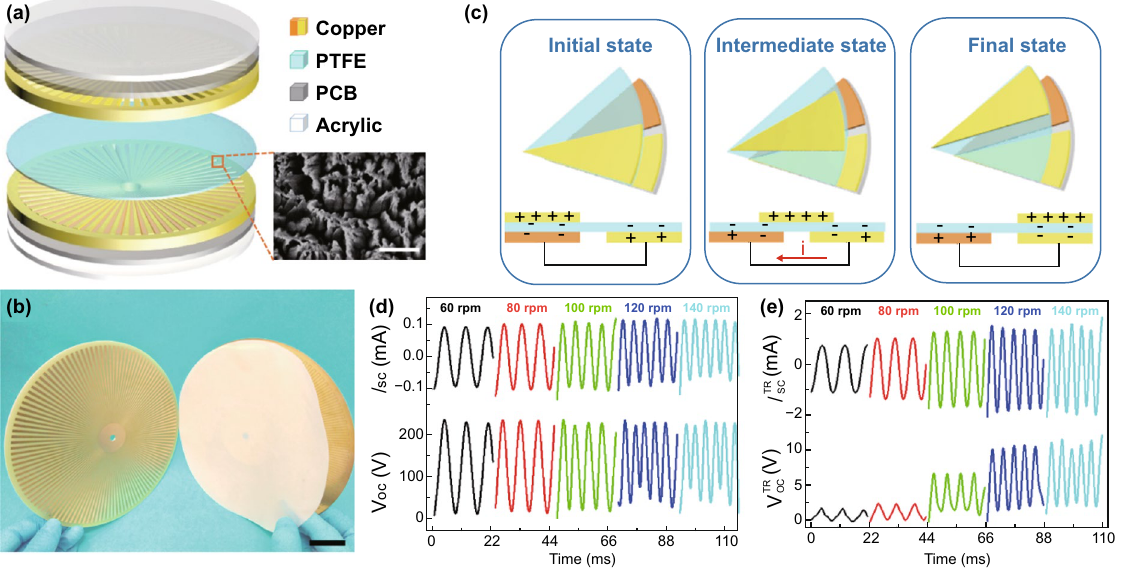
Fig. 3 Schematic illustration, working mechanism and output performance of mechanical energy harvester. a Schematic diagram of RD‑TENG. Inset: SEM image of PTFE surface with nanostructures (scale bar, 2 μm). b Photograph of the device model (scale bar, 2 cm). c Charge distribu‑ tions scheme of the device. d Open‑circuit voltage ( V oc ) and short‑circuit current ( I sc ) before transformation and e after transformation between 60 and 140